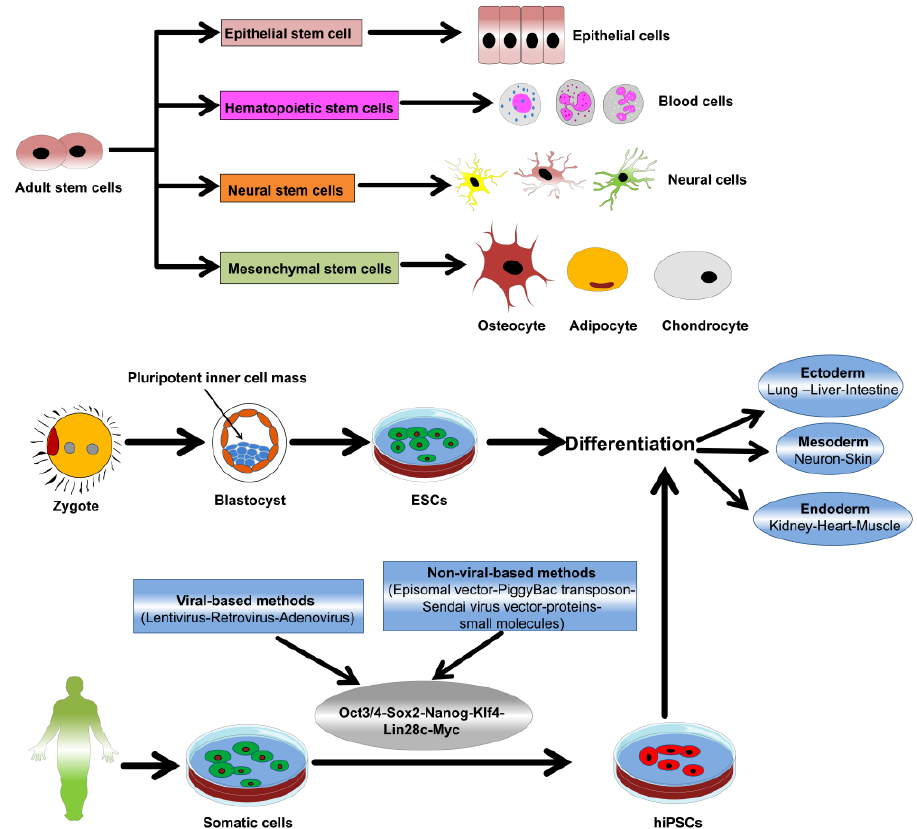
Figure 1. Representative diagram depicting the main types and sources of stem cells and their potential to differentiate into various lineages.